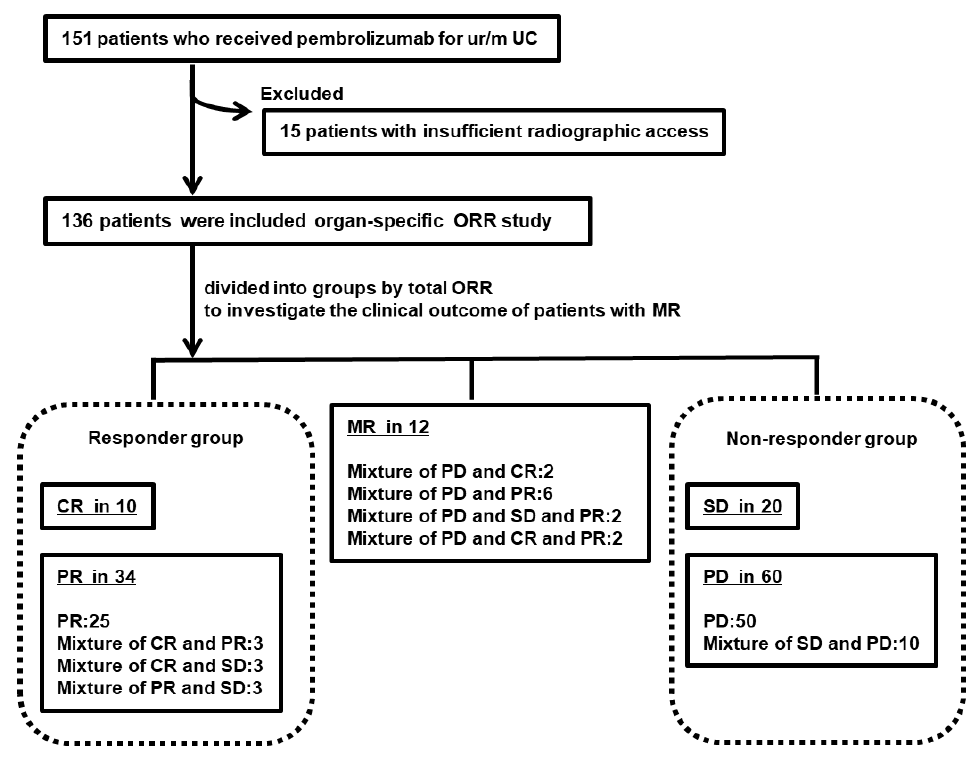
Figure 1. Study flow chart of organ-specific objective response rate (ORR) and mixed response (MR) to pembrolizumab for unresectable or metastatic urothelial carcinoma (ur/mUC). A total of 151 patients with ur/mUC treated with pembrolizumab were enrolled, but 15 were excluded because of a lack of data. The remaining 136 patients were examined for organ-specific ORR and clinical outcome of MR. The responder group included 10 patients with CR and 34 with PR. The non-responder group included 20 patients with SD and 60 patients with PD; there were 12 patients with MR. Table 1. Clinicopathological background factors of 136 patients and 3 groups.